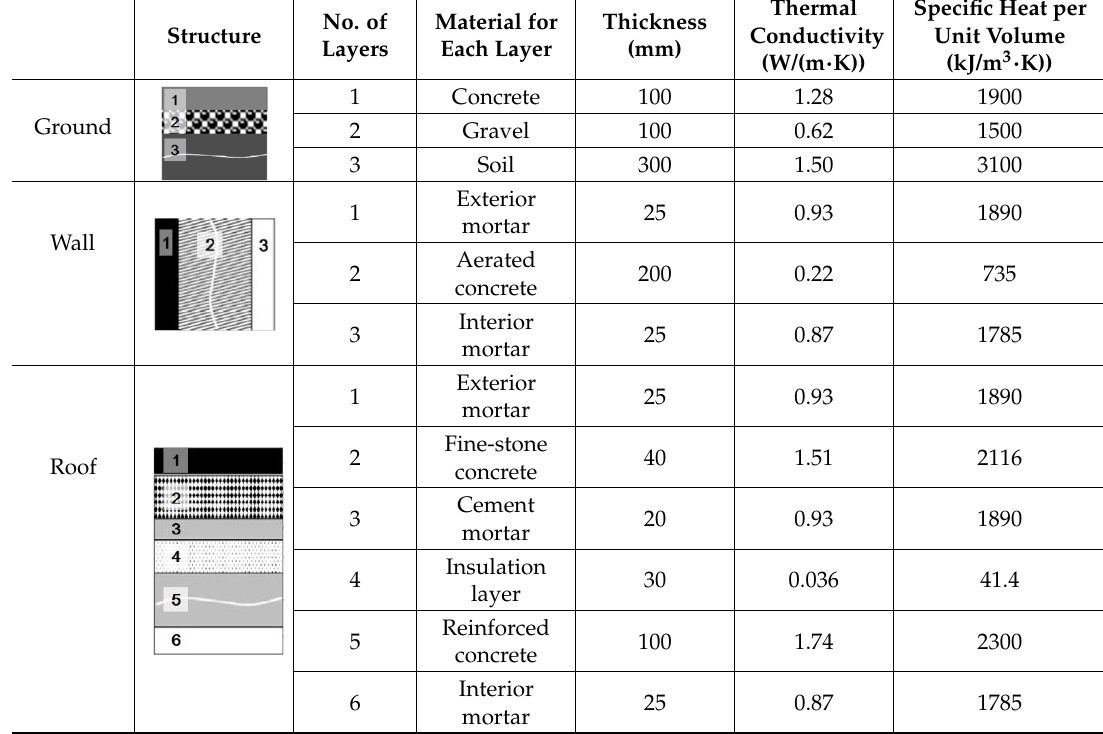
Table 7. The surface properties.